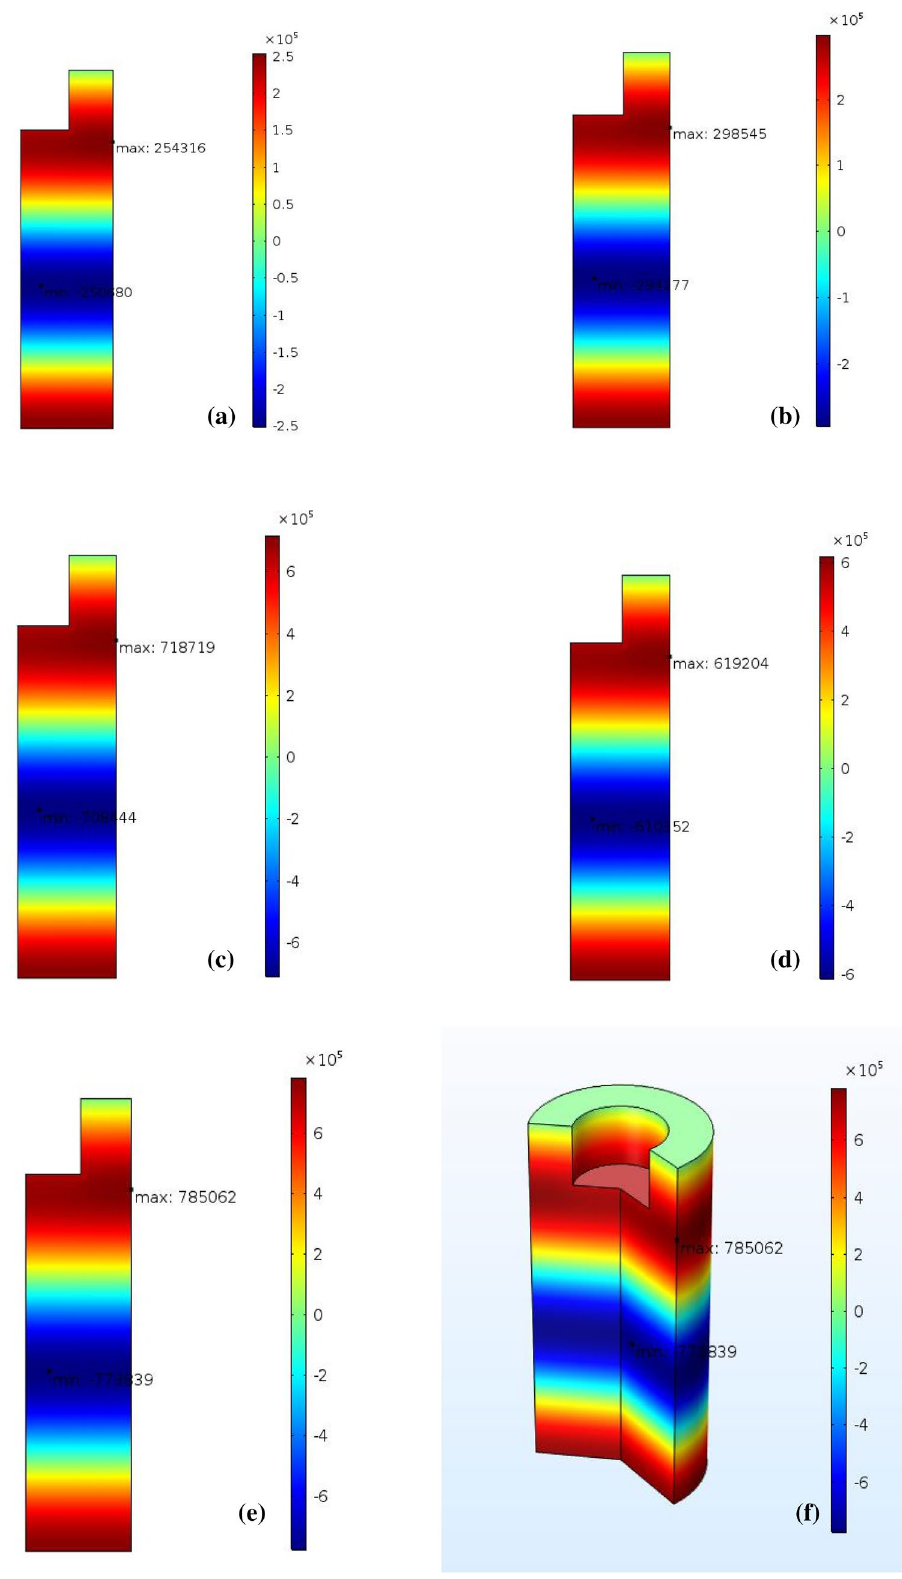
Figure 2. The effect of typical sonicator output power on the acoustic pressure distribution in the vessel: ( a ) 34 W, ( b ) 40 W, ( c ) 170 W, ( d ) 225 W, ( e ) 264 W, 2D, and ( f ) 264 W, 3D